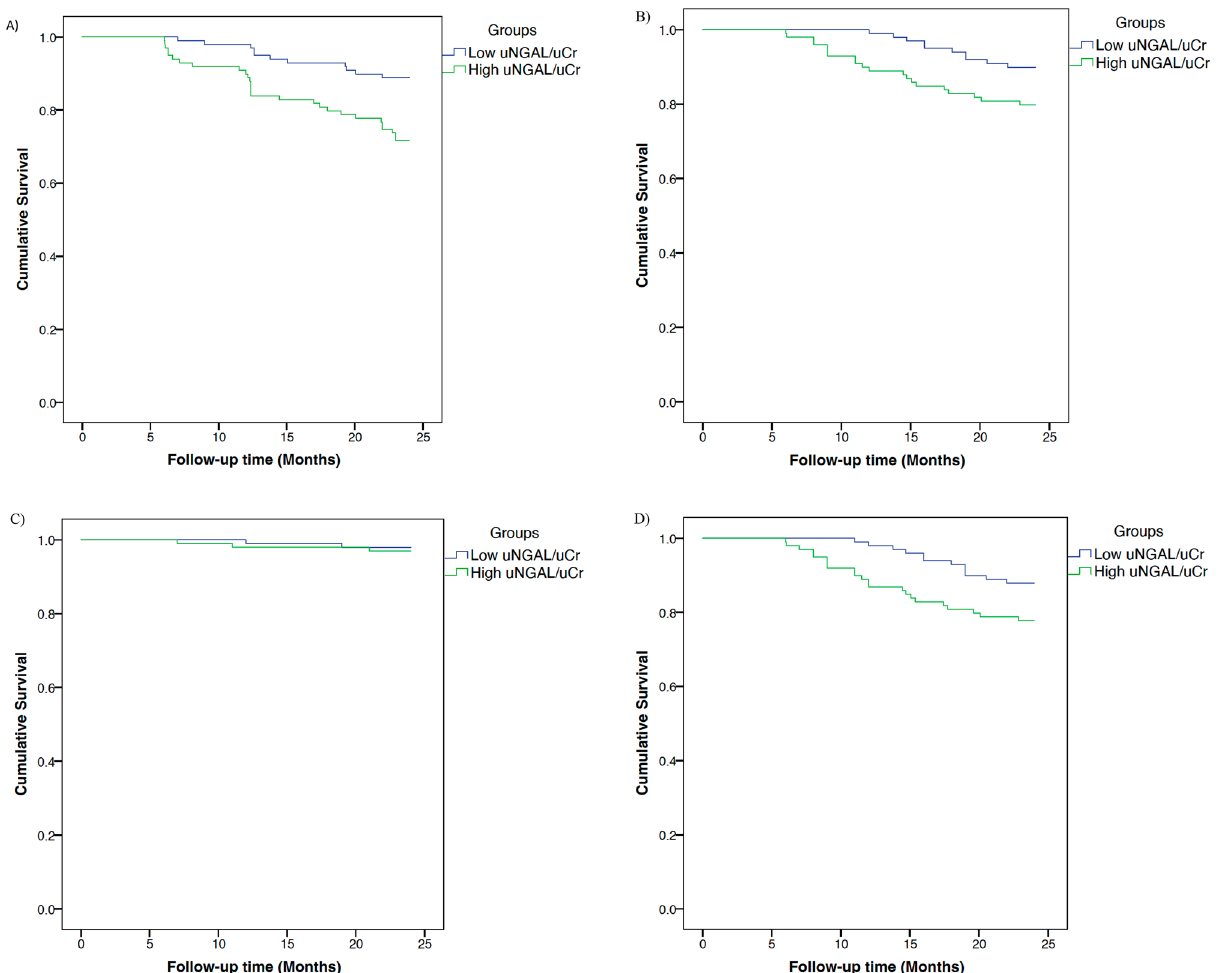
Figure 1. Kaplan–Meier analysis of PAD-related complications event-free survival in High uNGAL and Low uNGAL subgroups. Kaplan Meier estimate for event-free survival, including ( A ) ABI ≥ − 0.15, ( B ) vascular intervention, ( C ) major limb amputation, and ( D ) MALE, for Low NGAL group ( n = 99, uNGAL/ uCr ≤ 48.7 μg/g) compared to High NGAL (n = 99, uNGAL/uCr NGAL > 48.7 μg/g) based on the median uNGAL/uCr values. MALE = vascular Intervention and major limb amputation.